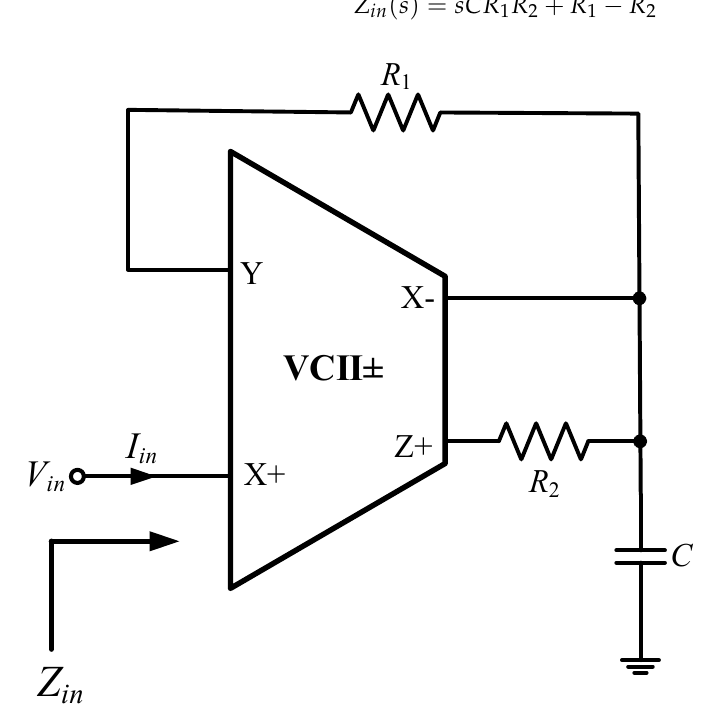
± -based simulated Figure 2. Proposed VCII±-based simulated inductor. Figure 2. Proposed VCII